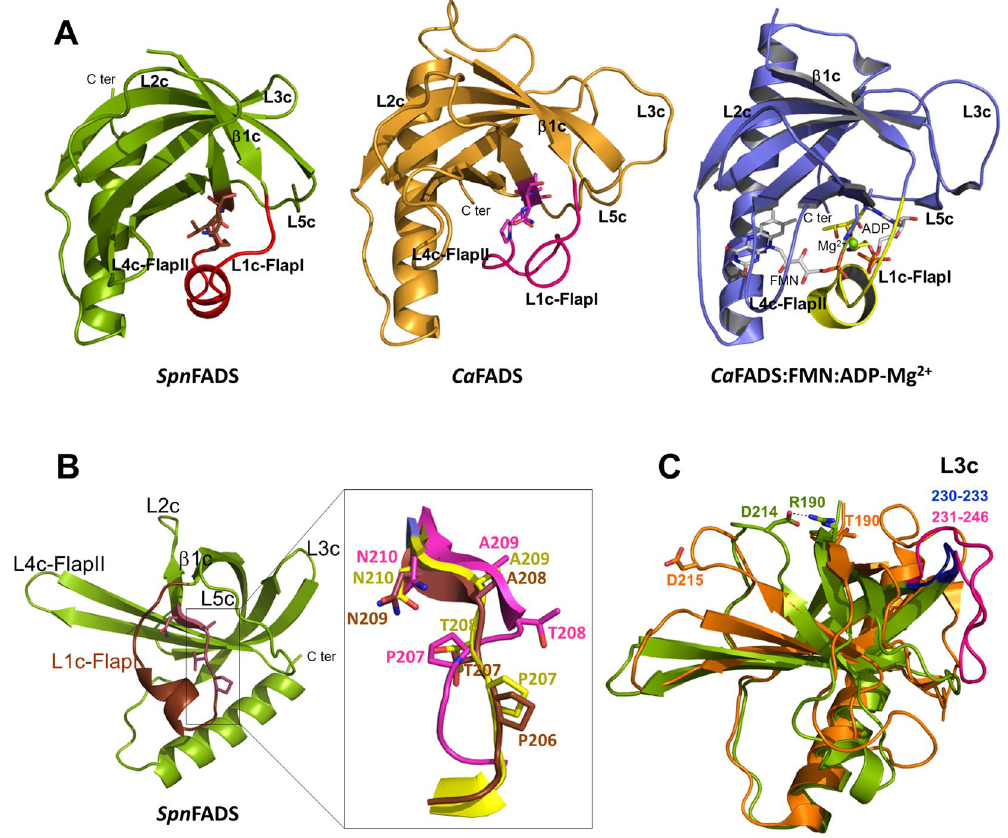
Figure 7. Comparative analysis of the RFK sites of Spn FADS, Ca FADS and the Ca FADS:FMN:ADP-Mg 2 + ternary complex. ( A ) Cartoon representation of the RFK domains of Spn FADS (green, PDB ID: 3OP1), Ca FADS (orange, PDB ID: 2X0K) and ternary complex of the RFK module of Ca FADS (blue, PDB ID: 5A8A). L1c-FlapI is highlighted in red, pink and yellow, respectively. Residues of the PTAN motif are in CPK sticks. The FMN and ADP ligands bound to the Ca FADS RFK module are in white CPK and Mg 2 + is included as a green sphere. ( B ) Detail of the PTAN motif in Spn FADS and superposition of the PTAN motives of the three structures. ( C ) Superposition of the RFK domain of Spn FADS (green) and Ca FADS (orange). The salt bridge between D214 at L2c and R190 at β 1c of Spn FADS is in black dashes. Equivalent residues in Ca FADS, D215 and T190, are drawn in sticks. Loops L3c are colored in blue ( Spn FADS) and pink ( Ca